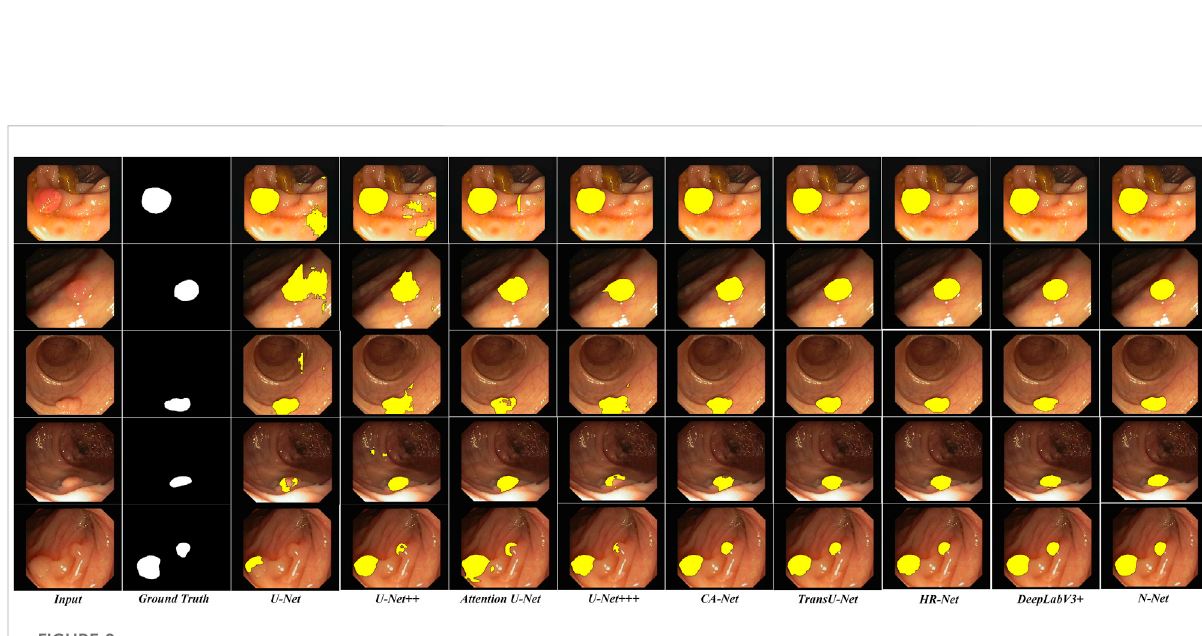
FIGURE 9 Segmentation results of the N-Net and the state-of-the-art methods on representative images of the CVC-ClinicDB dataset.